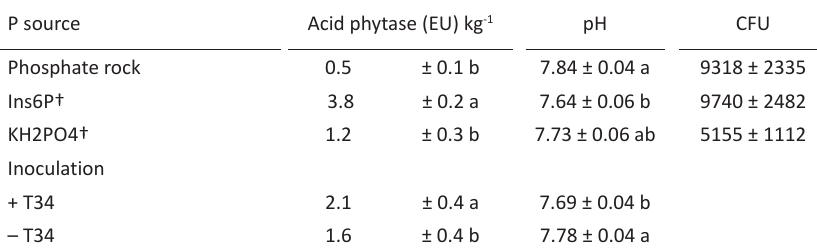
Table 4. Effects of the main factors on properties of the plant growing media